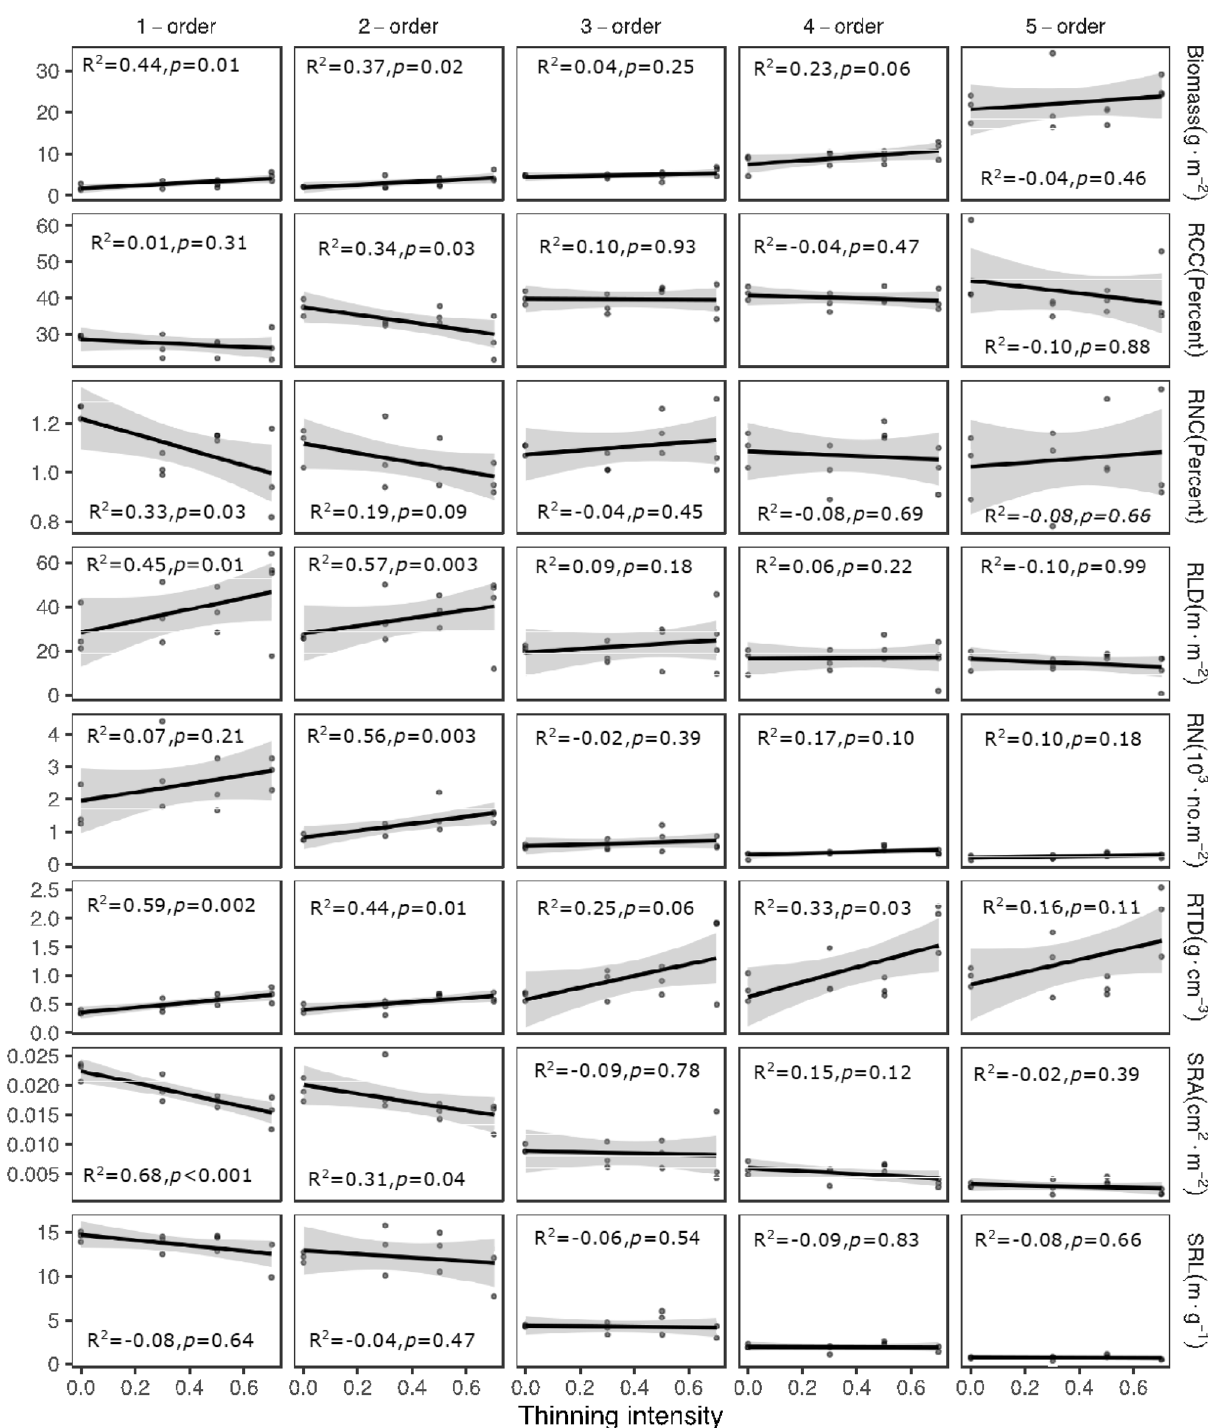
Figure 1. Variation in functional traits of the first five orders roots along the thinning intensity. Adjusted R -squared and p value of the linear regression models (according to the linear regression analysis) for the first five root orders are showed. Regression lines with 95% confidence intervals (grey shades) show the prediction of linear